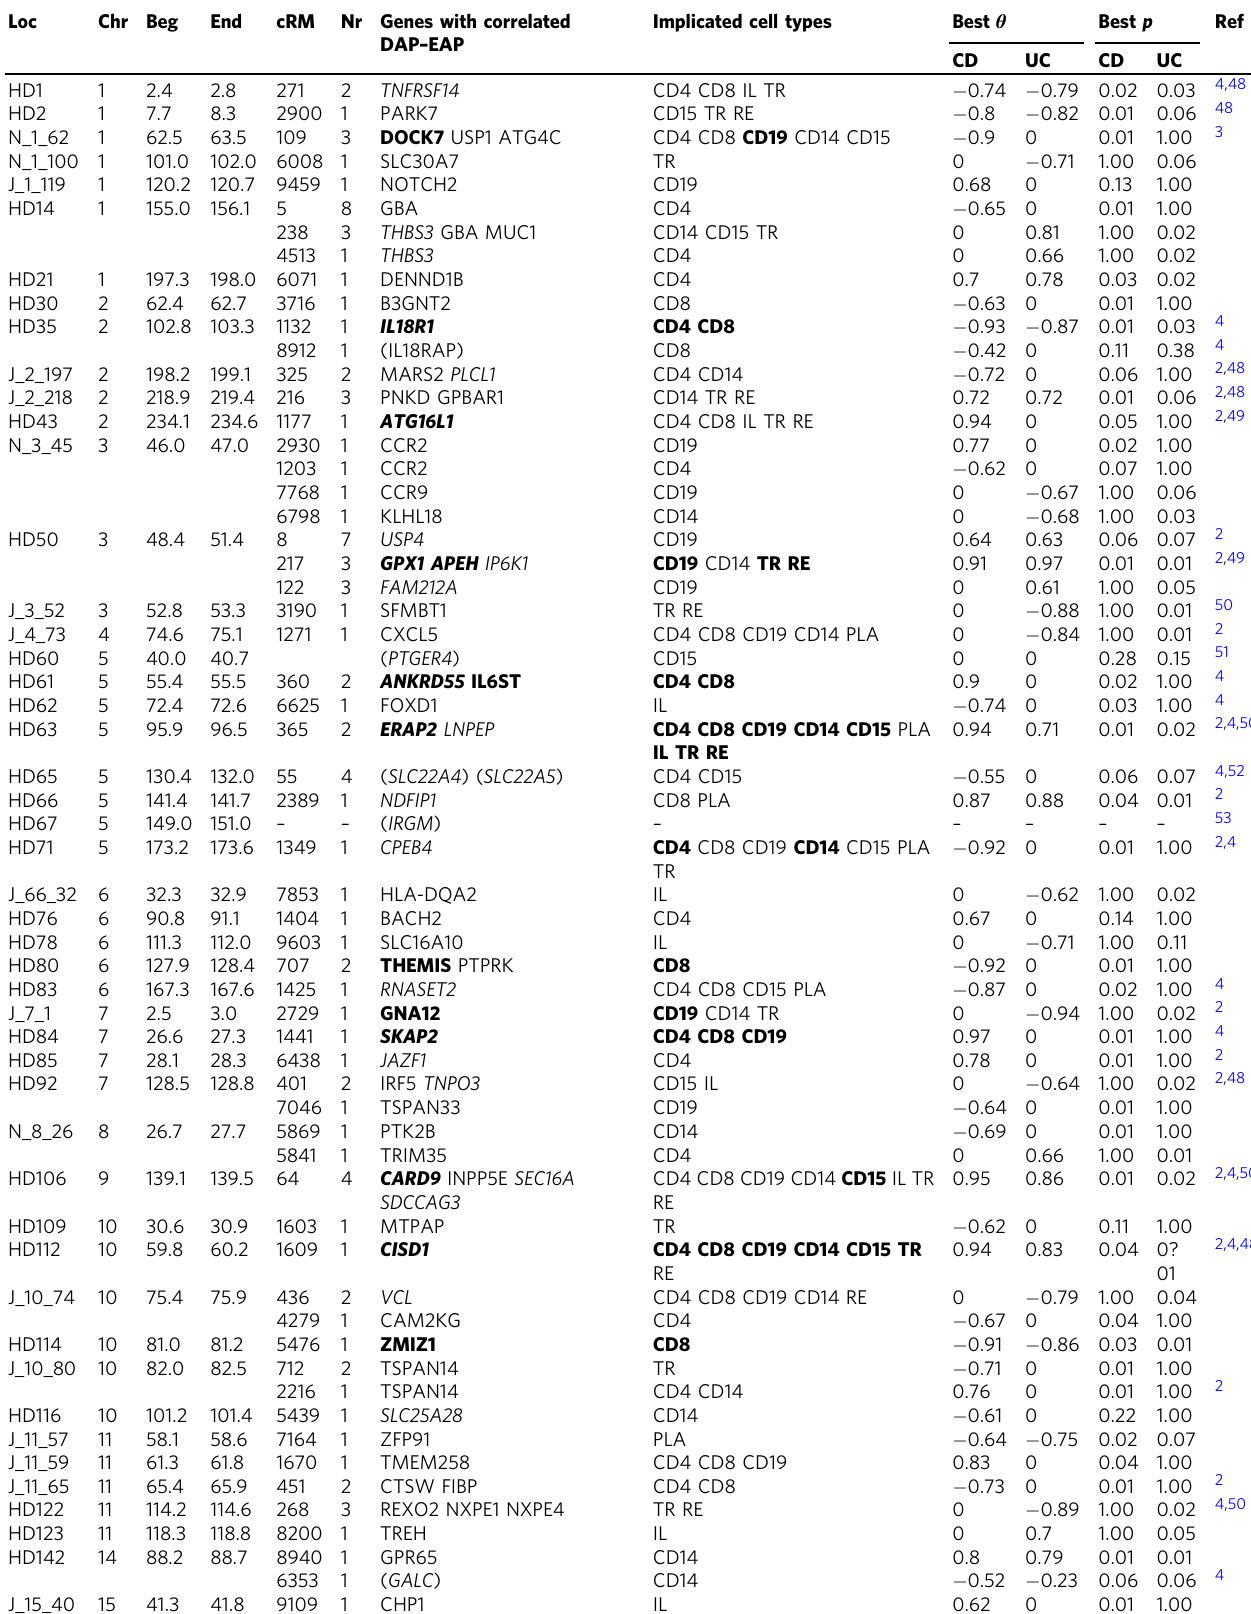
Table 1 IBD risk loci for which at least one cis -eQTL association pattern (EAP) was found to match the disease association pattern